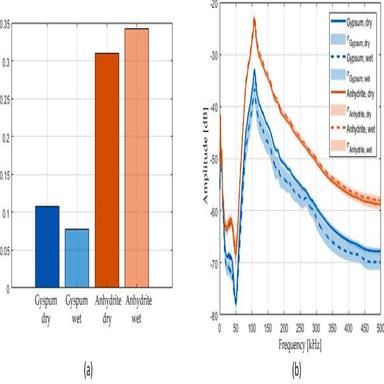
Average RMS of the AE signal (a) and frequency spectra (b) of wet and dry material.